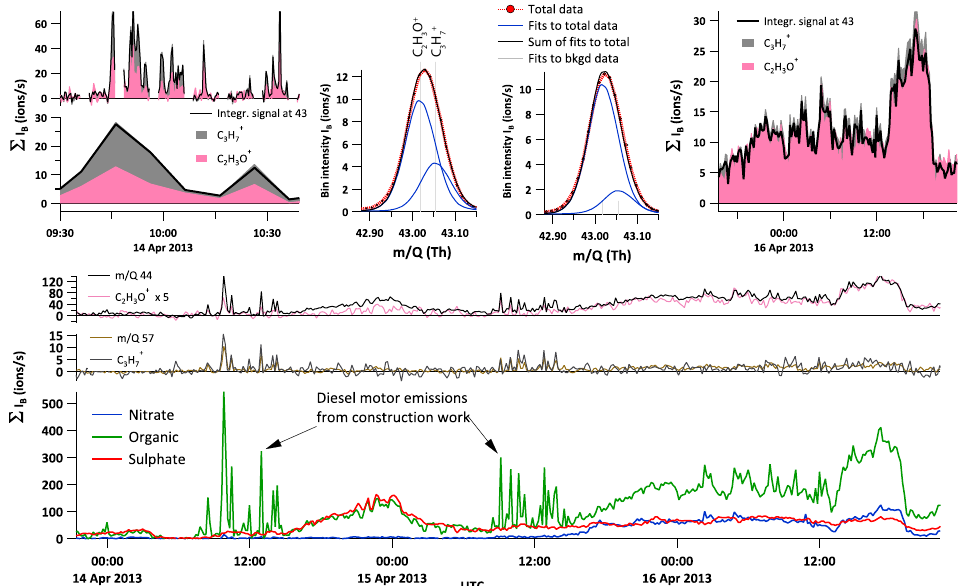
Fig. 9. Bottom: time series of organic and inorganic species measured by the ToF-ACSM at the Jungfraujoch. The integrated signal over the unit masses 44 and 57 is also shown. Top left: time series of high-resolution peak fits for two ions at m/Q = 43Th over a period with local emissions, together with the average mass spectrum for unfiltered data from this period. The peak fits for both filtered and unfiltered data are indicated in the plot. Top right: same for a period without influence of local emissions. All signals are shown in ions of the respective compounds per